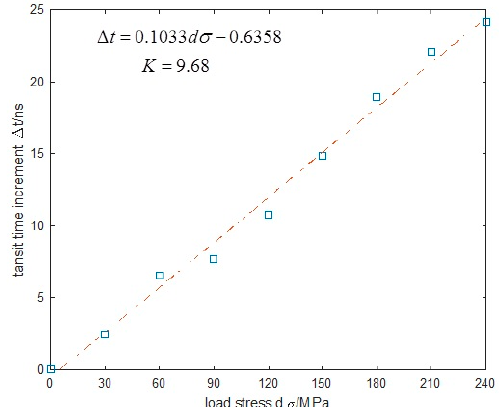
Figure 6. Tension versus transit time. (Test conditions: frequency of transducers: 5 MHz, the distance between transmitting transducer and the first reveiving transducer: 37.6 mm, specimen: 304 stainless steel, environment temperature:26 degrees Celsius, K : the acoustoelastic constant.)